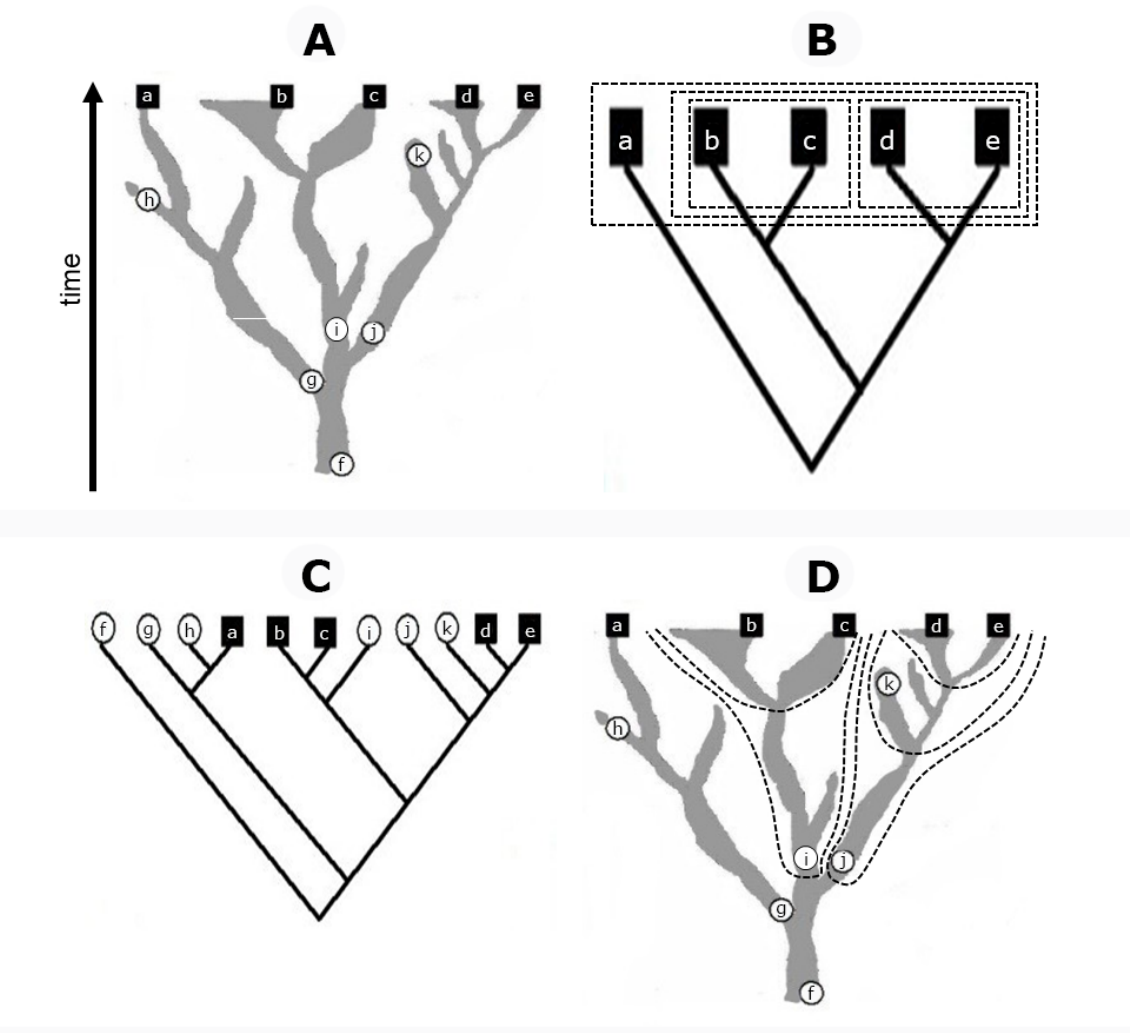
Figure 1 Comparison of Linnaean and phylogenetic classifications using hypothetical example diagrams. ( A ) Phylogenetic coral model for a branched evolutionary lineage, assuming that five populations represent extant species (a–e) and six populations represent known fossil species (f–k). ( B ) The correct synchronous cladogram for the extant species corresponds to the backbone tree of the coral, from which monocladistic Linnaean taxa may be derived (boxes: all members of each taxon share the same nearest hypothetical ancestor, which has no other descendants). ( C ) The correct asynchronous cladogram for all known species does not correspond to any backbone tree because extinct species may be either ancestors (f, g, i, j) or sisters (h, k) to extant ones, although clades may nevertheless be used to identify branches of the coral, i.e., monophyletic groups [some are outlined in ( D ): each taxon includes a common ancestor and all of its descendants]. The Linnaean classification is not meaningful for extant and extinct species taken together, because the morphological gap observed between {b, c} and {d, e} at the present time horizon diminishes for their ancestors (i and j), that is, Linnaean ranks are not valid historically, unlike coral branches. Phylogenetic nomenclature is adopted here to assign names to the latter. For details, see Podani (2010,